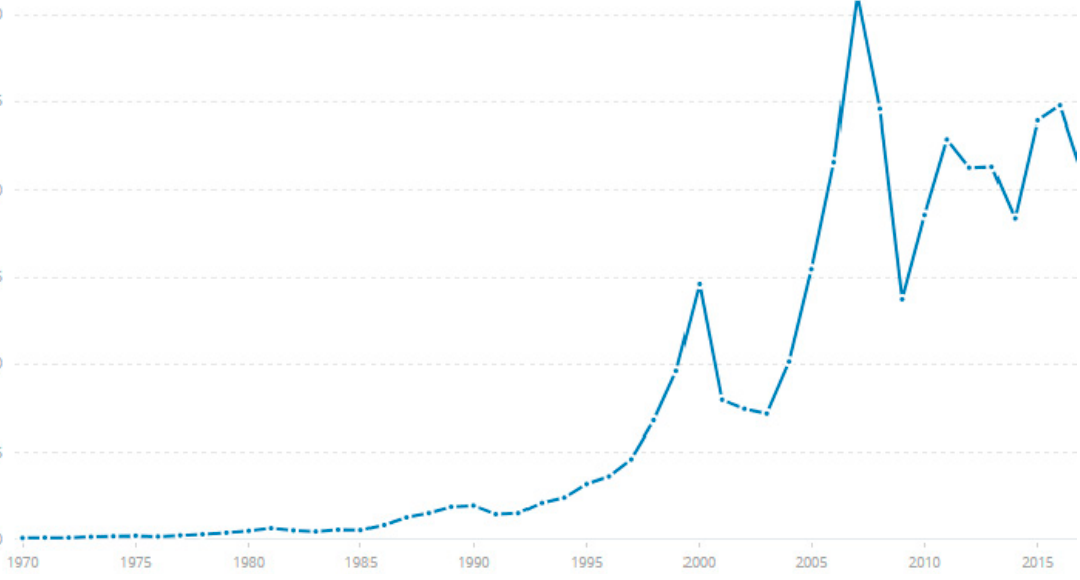
Figure 1. World net foreign direct investment (FDI) inflows: 1970–2017. y-axis: in current trillion US$. Source: https://data.worldbank.org/indicator/BX.KLT.DINV.WD.GD.ZS?view=chart